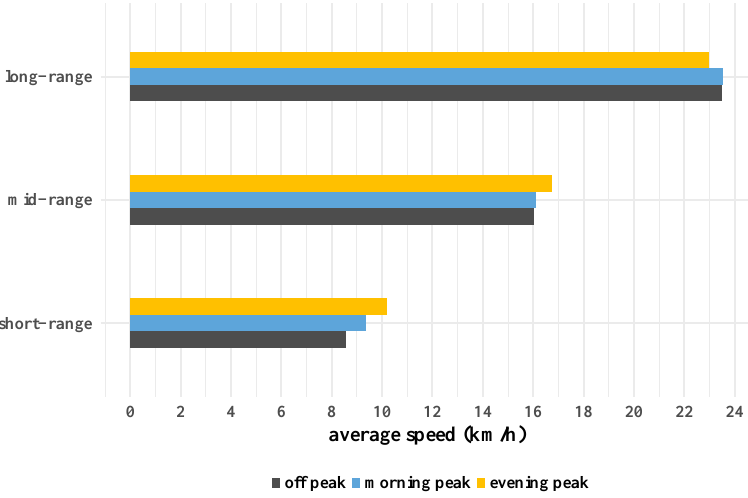
Figure 7. Average speed per on/off peak during working days.